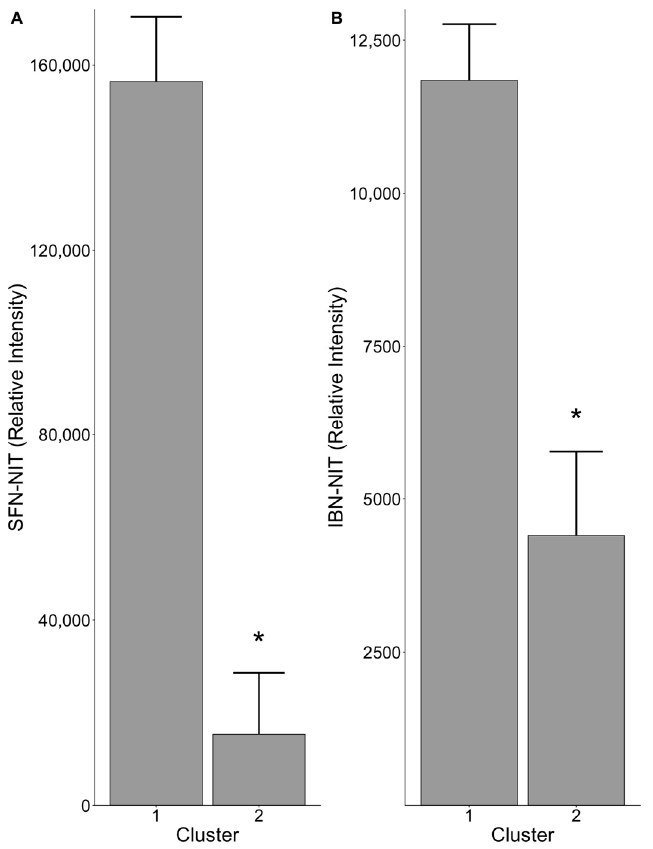
Figure 3. ( A ) SFN-NIT and ( B ) IBN-NIT levels detected in fecal cultures ( n = 5/cluster) following anaerobic incubation with broccoli sprouts for 24 h. Cluster corresponds to the microbial communities detected through PCoA analysis (Figure 2). Error bars show SEM. Asterisks denote statistically significant differences ( p < 0.05).